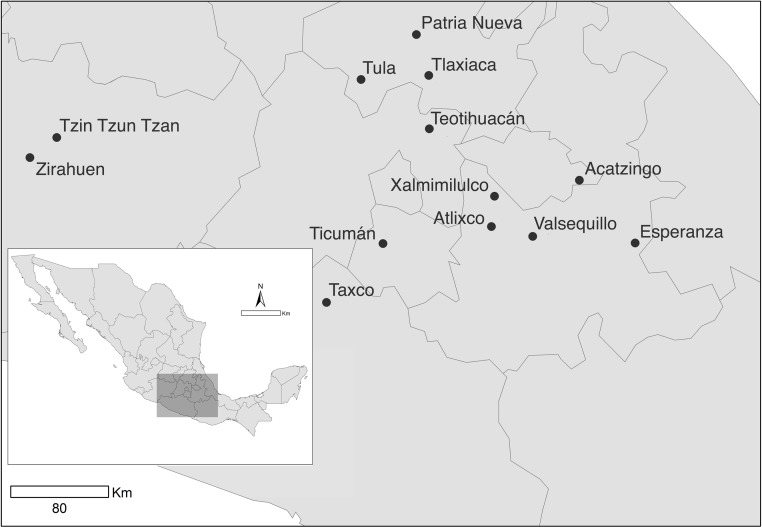
Sampled populations of Datura stramonium in central Mexico (see Table 1).